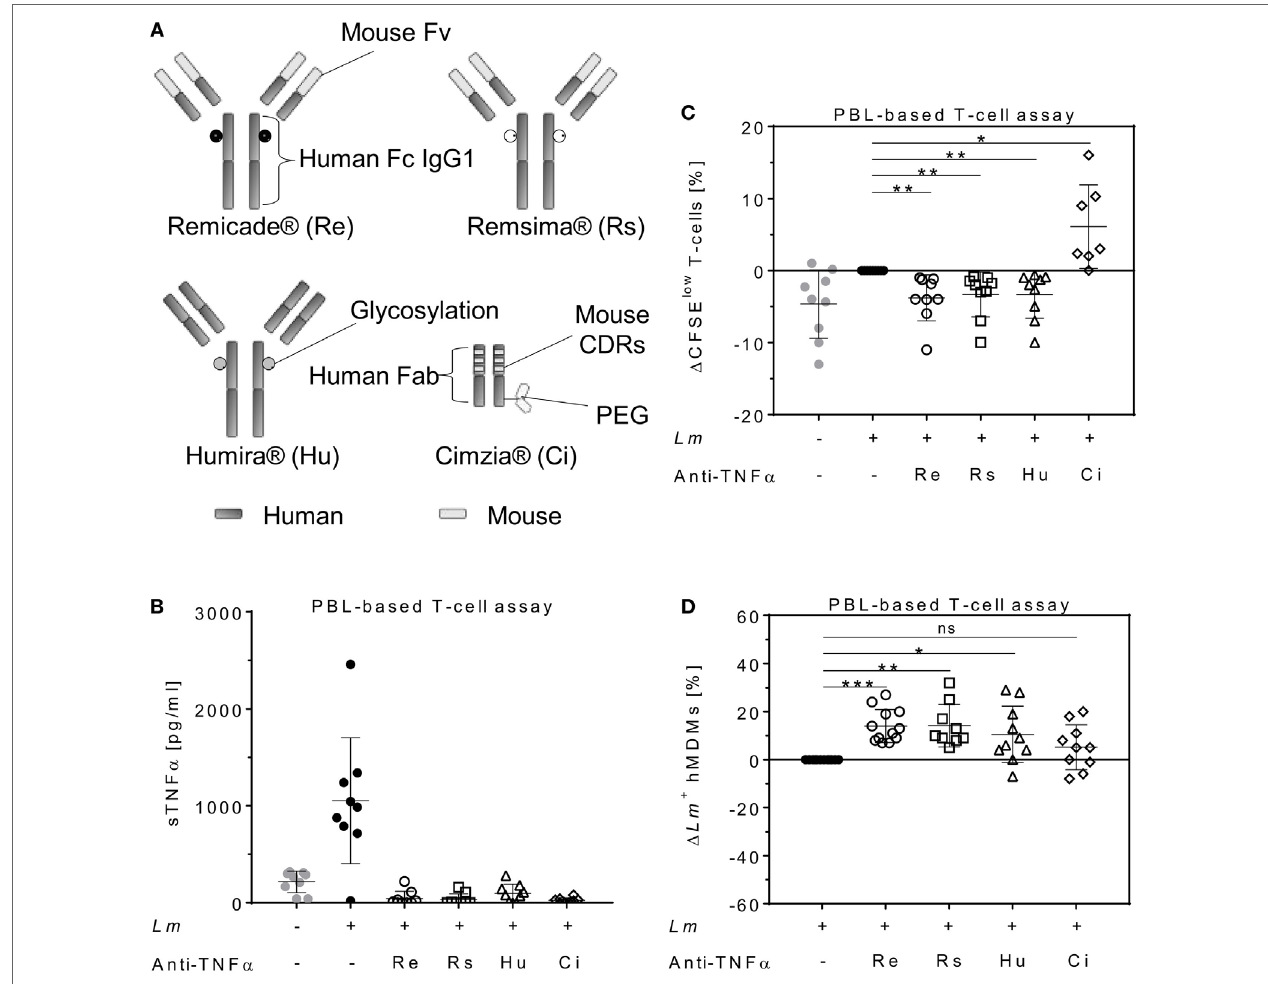
FigUre 3 | TNF α blockers have diverging effects on T-cell proliferation and Lm infection rates. (a) Schematic representation of the TNF α blockers Remicade ® (Re), Remsima ® (Rs), Humira ® (Hu), and Cimzia ® (Ci). (B–D) Lm (MOI = 20) were added to hMDMs for 3 h. Subsequently, extracellular parasites were removed by washing. Anti-TNF α agents (Re ○ , Rs □ , Hu Δ and Ci ◊ ) were added 24 h after Lm infection ( − Lm ● , + Lm ● ) of hMDMs and incubated in the presence of CFSE-labeled autologous PBLs. (B) The concentration of sTNF α was measured by ELISA 7 days post-infection. T-cell proliferation (c) and Lm infection rates in hMDMs (D) were analyzed by flow cytometry after 7 days. (c,D) Values of the corresponding controls were subtracted for each donor and condition to illustrate differences. Results are presented as mean ± SD ( n ≥ 7) and at least four separate experiments were conducted. The Wilcoxon signed-rank test was performed to evaluate statistical significance. * P < 0.05; ** P < 0.01; *** P < 0.001. Abbreviations: CDRs, complementarity determining regions; Fv, fragment variable; TNF α , tumor necrosis factor α ; Lm, Leishmania major; MOI, multiplicity of infection; hMDMs, human monocyte- derived macrophages; PBLs, peripheral blood lymphocytes; sTNF α , soluble TNF α